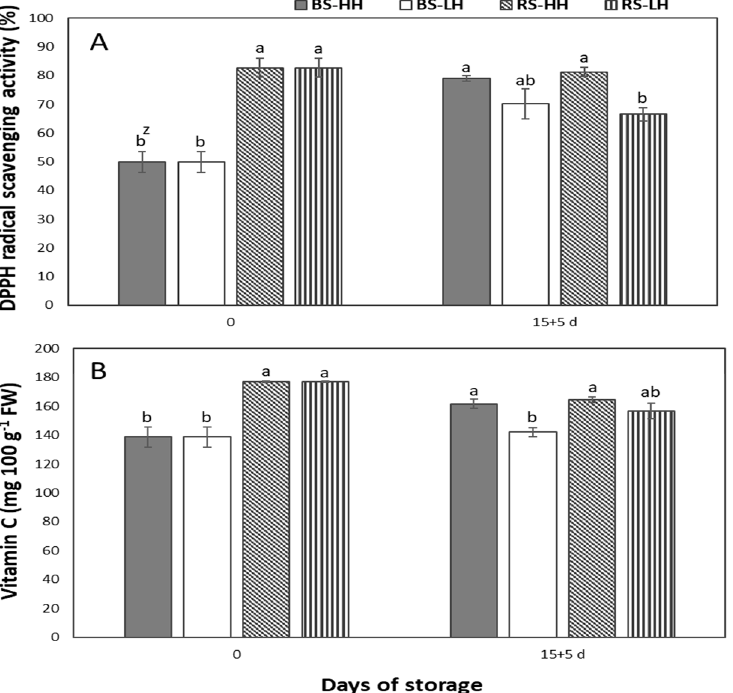
Figure 4. High and low RH effects on the sweet pepper’s DPPH radical scavenging activity ( A ) and vitamin C ( B ) before and on the final day after 15 days of cold storage at 5 °C and 5 days at ambient conditions. Vertical bars represent ± SE of the mean ( n = 3). Z Different letters represent significant differences among treatments for each sampling day using Tukey’s multiple comparison test at p < 0.05. Note: 15 + 5 d means the fifth day in ambient conditions.